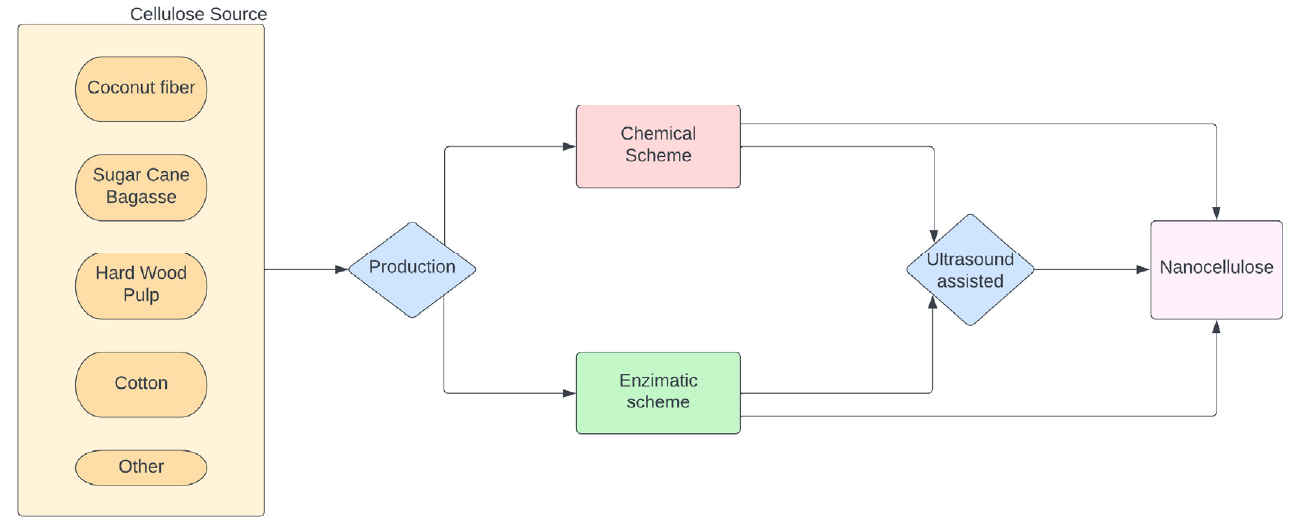
Figure 3. System boundary of cradle-to-gate production of nanocellulose.